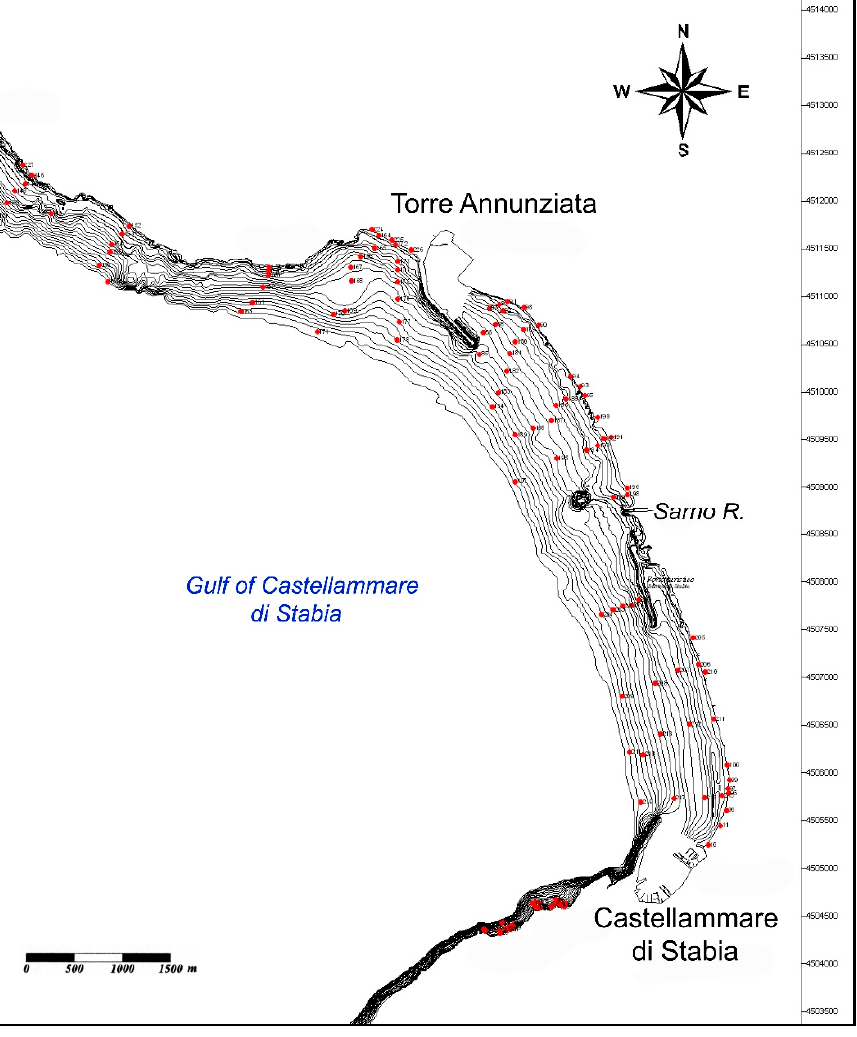
Figure 11. Location of sampling sites; isobaths: 1 m interval.